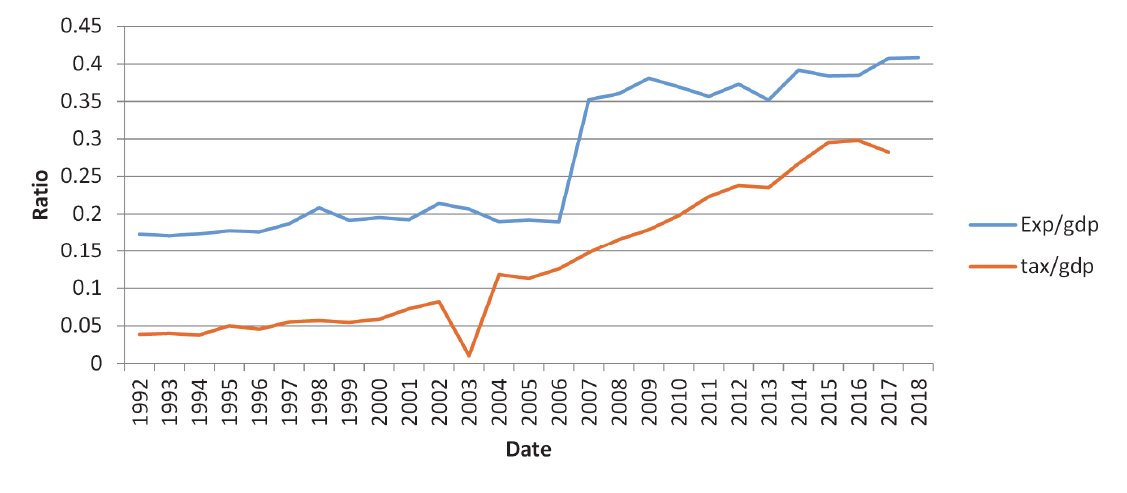
Fig. 1. Tax Revenue to GDP and Expenditure to GDP Ratios in Lesotho During 1992 to 2018 Source: Authors computations using Central Bank of Lesotho and Lesotho Revenue